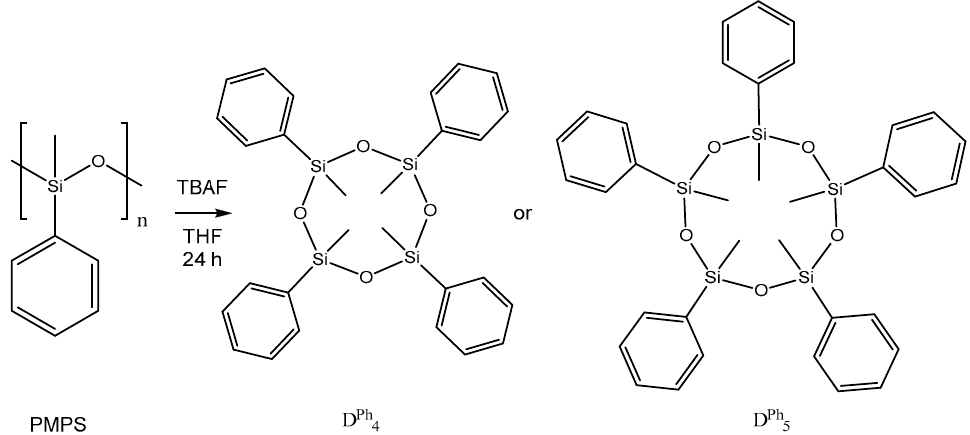
Figure 3. Fluorine-ion-catalyzed depolymerization of polyphenylmethylsiloxane. Adapted with permission from Ref. [29], copyright 2021, American Chemical Society.